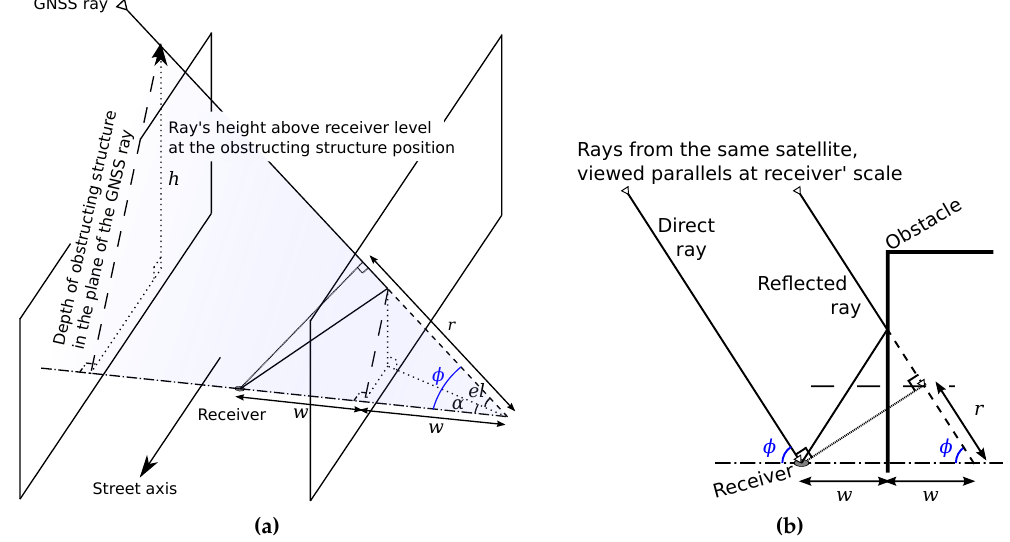
Figure 15. GNSS ray trajectory in the case of one reflection before reaching the receiver. ( a ) 3D illustration; ( b ) Cross-section following the plane of the GNSS ray and